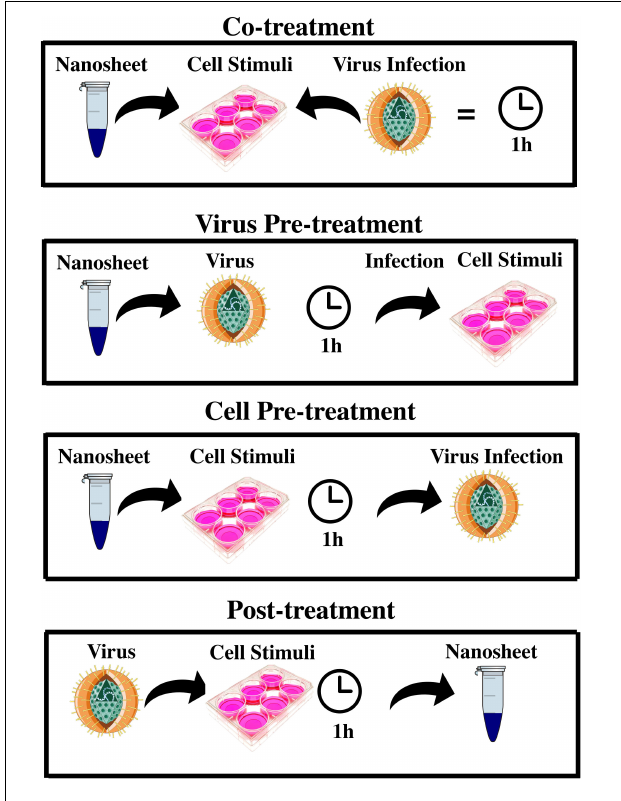
FIGURE 6 | Different schemes of experimental antiviral assay. It shows the different interaction schemes of 2D MoS 2 and GO with HSV-1 and Vero cells exhibiting very intriguing results in either cases (2D MoS 2 and GO